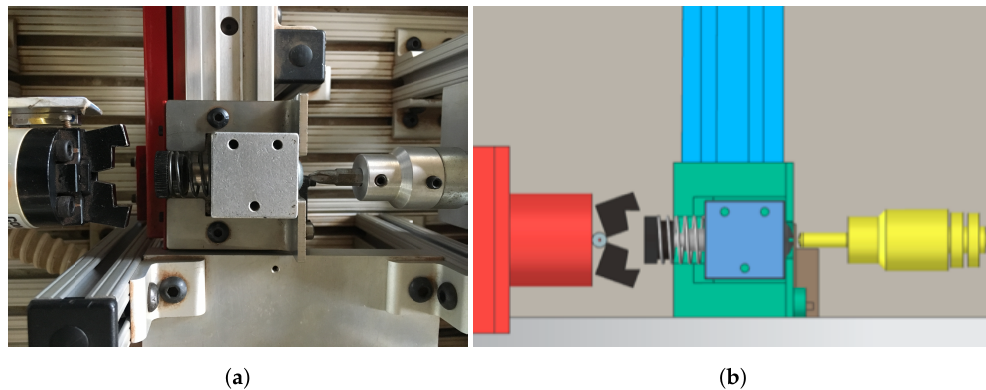
Figure 14. ( a ) machine, clamp open after torquing; ( b ) virtual model, clamp open after torquing.